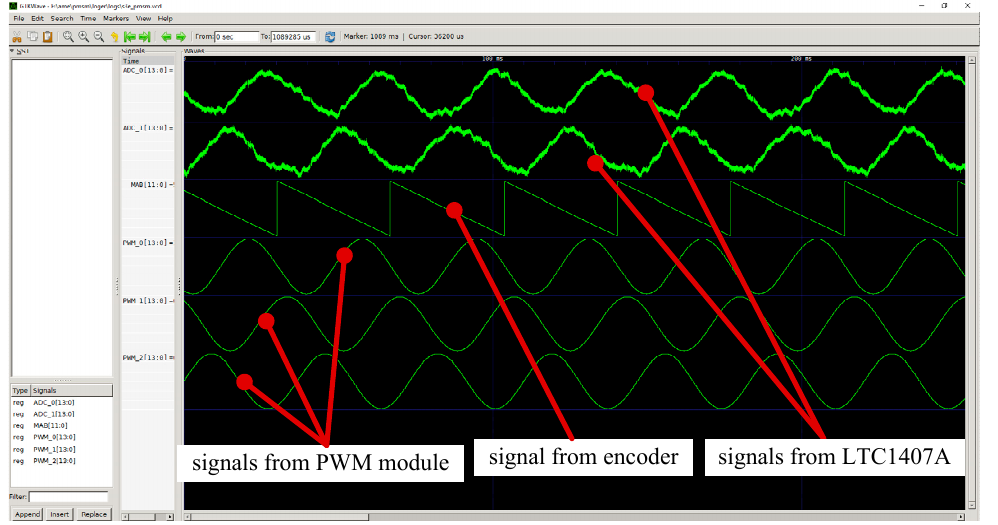
Figure 15. Signals from the LTC1407A, signals from the encoder, and signals from the PWM module.